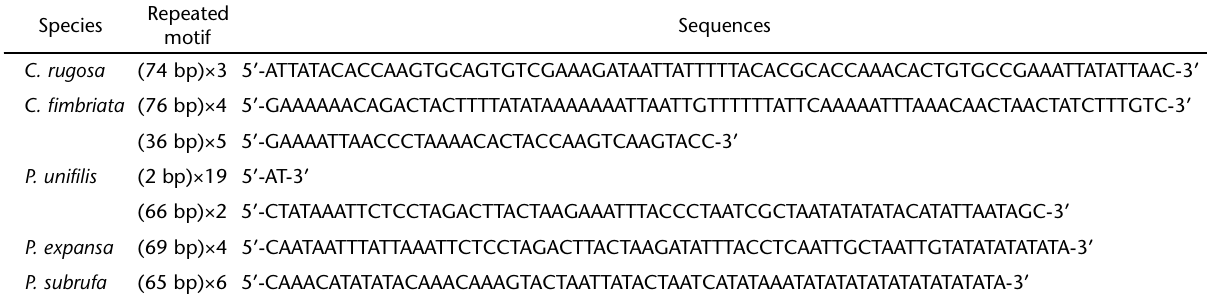
Table II. Comparison of the repeat units in CR of the five pleurodiran turtles analyzed in the present study. Repeated Species motif